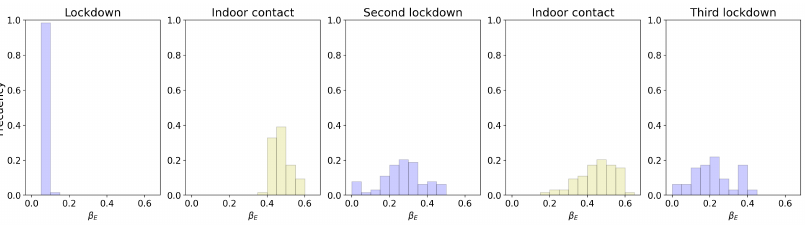
Figure 11. Histogram of the 64 different counties of United Kingdom. The value of β E at the different levels of lockdown registered in 2020.